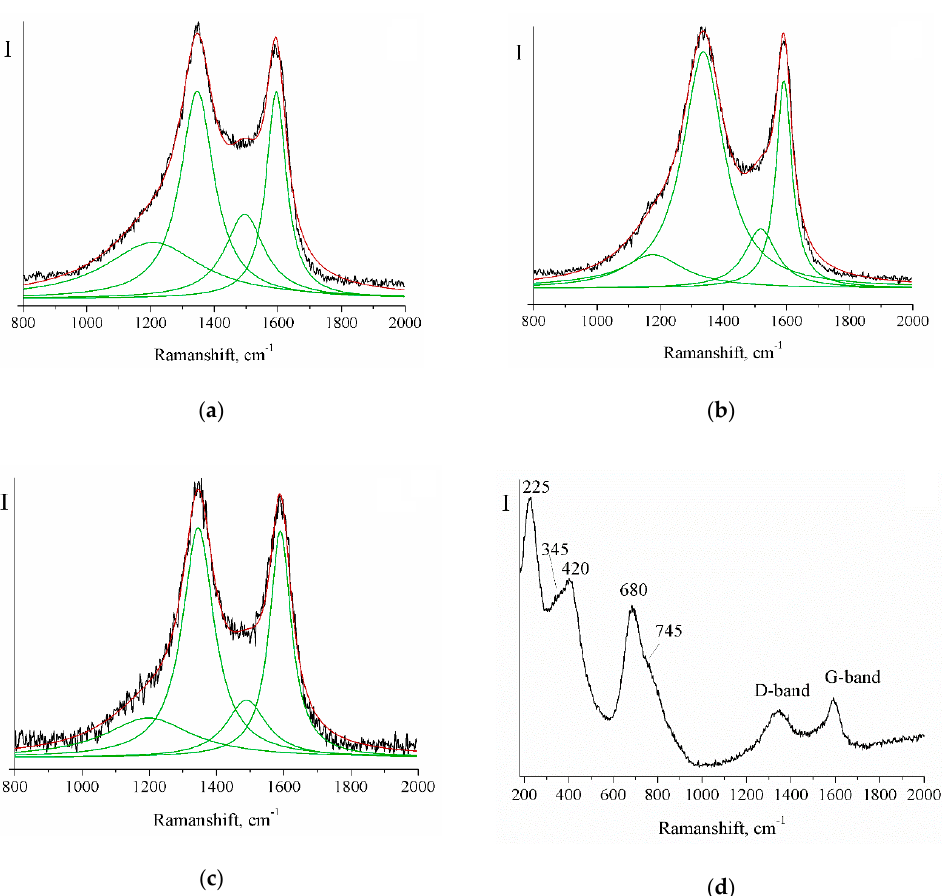
Figure 1. Raman spectra of the mesoporous carbon G_157M ( a ), carbon replica CR ( b ), carbon black CB ( c ), and the LTO/5%CR composite ( d ).